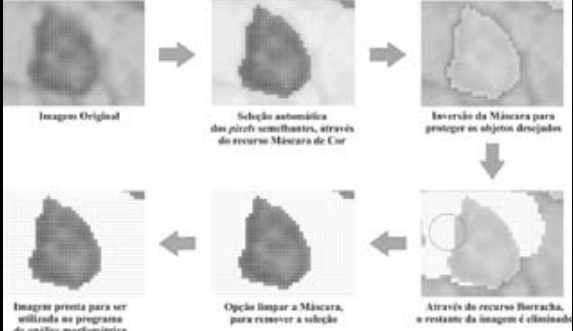
Figura 2 – Método adotado para isolar os objetos de pixels semelhantes utilizando o software Corel Photo Paint